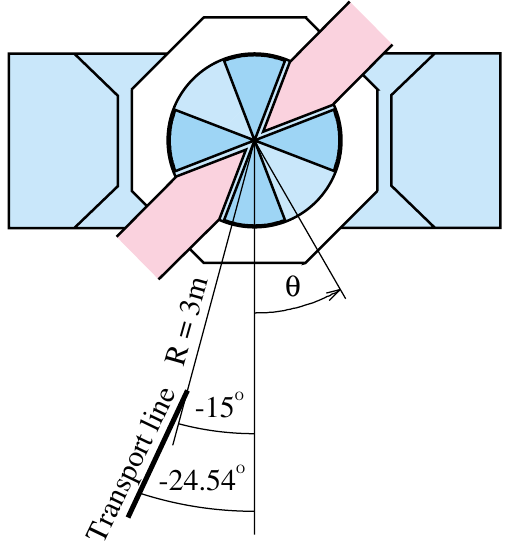
FIG. 2. (Color) Schematics of the VINCY Cyclotron. The me- dian plane cross sections of the yoke, pillars, pole (light blue), vacuum chamber (white), and rf resonators (pink) are shown. The azimuthal coordinate system used further throughout the paper is defined by its referent zero-angle axis and the positive (cid:6) direction. Also shown are the required direction and place- ment of the high-energy transport line. FIG. 1. (Color) Operating diagram of the VINCY Cyclotron. The dependence of the desired ion energy per nucleon, at the (cid:4) 5 mm1 mrad (cid:15) (cid:4) 5 (cid:15) mm mrad . 12 (cid:15) mm mrad and " z extraction radius of 0.86 m, T , on the needed magnetic field in , is shown. The specific charge of an ion, the machine center, B 0 (cid:3) , is used as a curve parameter. The calculations are performed using Gordon’s procedure and the measured magnetic field maps. The horizontal sides of the four rectangles define the lower and upper limits of the rotation frequency, i.e., extraction energy, of an ion accelerated using the first, second, third, or fourth harmonic modes of the rf system. The left border of the operating range is set by the trim coils capability to account for the maximum of 450 mT difference between the isochronous field and the field obtained by the main coils only. For (cid:3) (cid:5) 0 : 5 the right border corresponds to the maximum main coils current of 1000 A, while for (cid:3) (cid:4) 1 the largest obtainable energy is set by the focusing capabilities of the